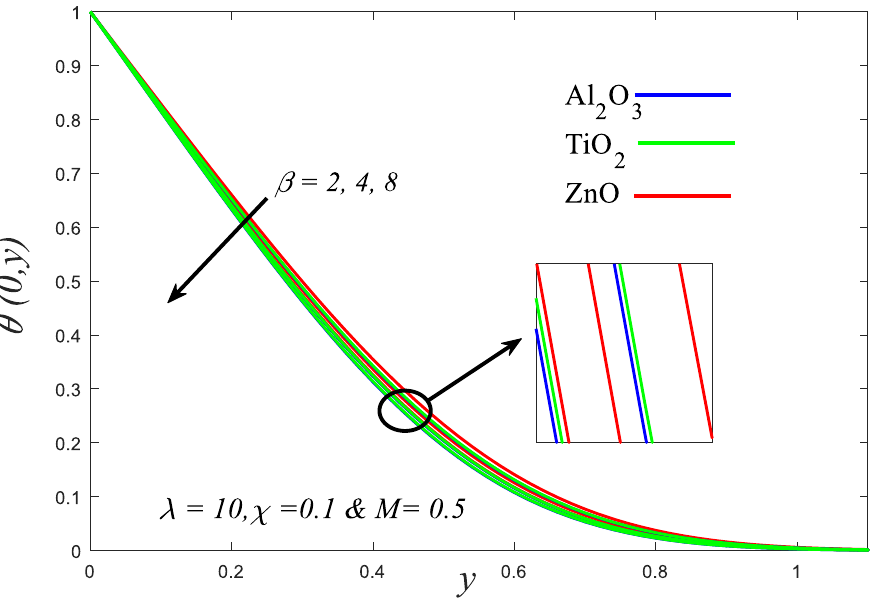
Figure 14. Impression of β on θ . The inset is a partial enlargement of the